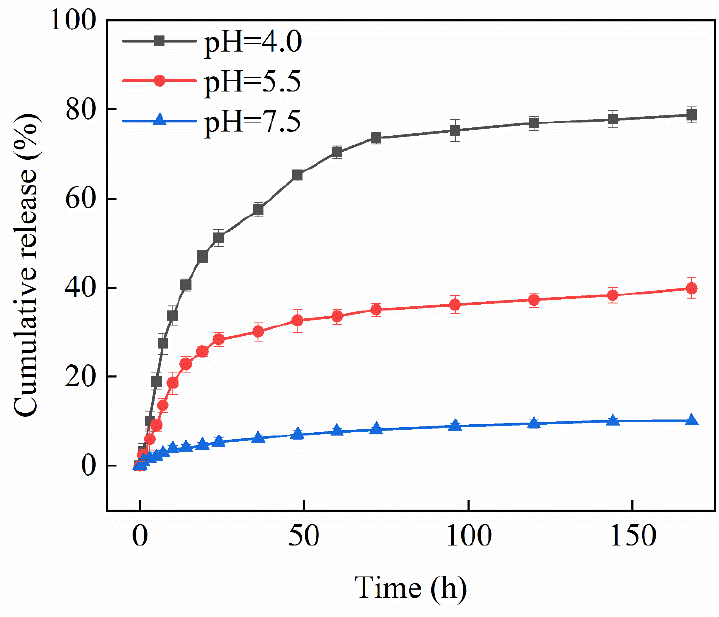
Figure 6. Effects of pH on the release behavior of Pro@HMS-TA-Cu.